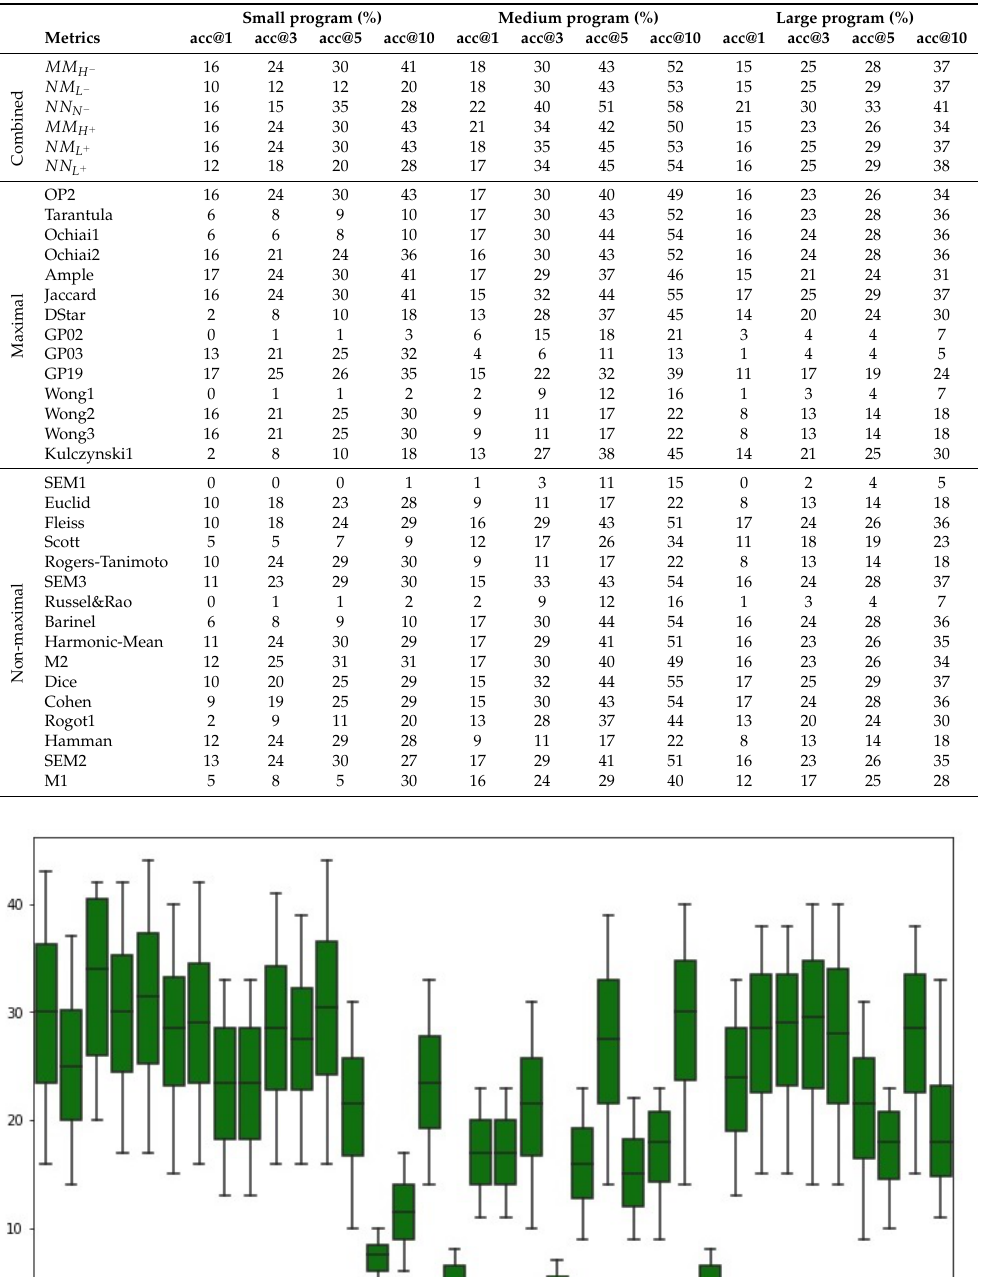
Table 7. Performance comparison of the combined risk evaluation metrics with the standalone risk